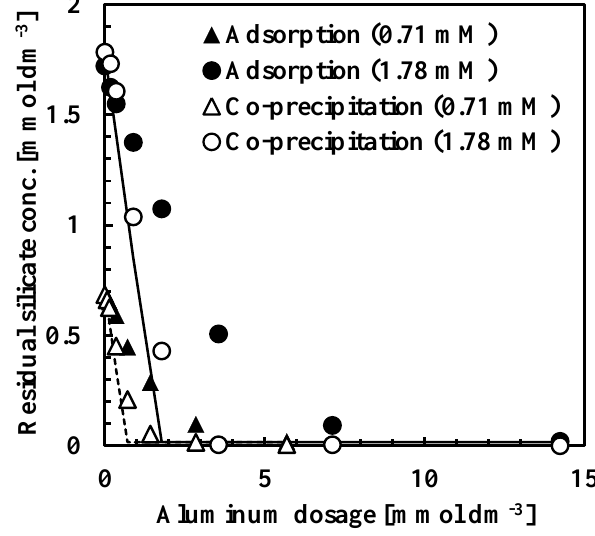
Figure 1. Silicate removal by co-precipitation and adsorption. Solid or dashed lines are calculated values considering the chemical equilibrium of kaolinite formation. The initial silicate concentration was either 0.71 or 1.78 mmol·dm −3